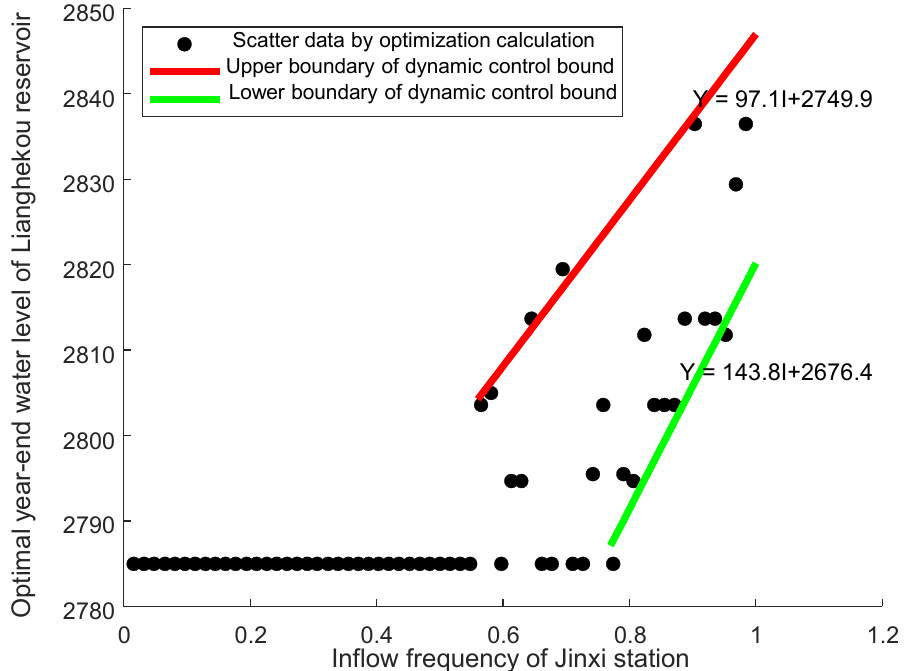
Figure 8. Dynamic control bound of yearly drawdown level constructed by inflow series of Jinxi station.